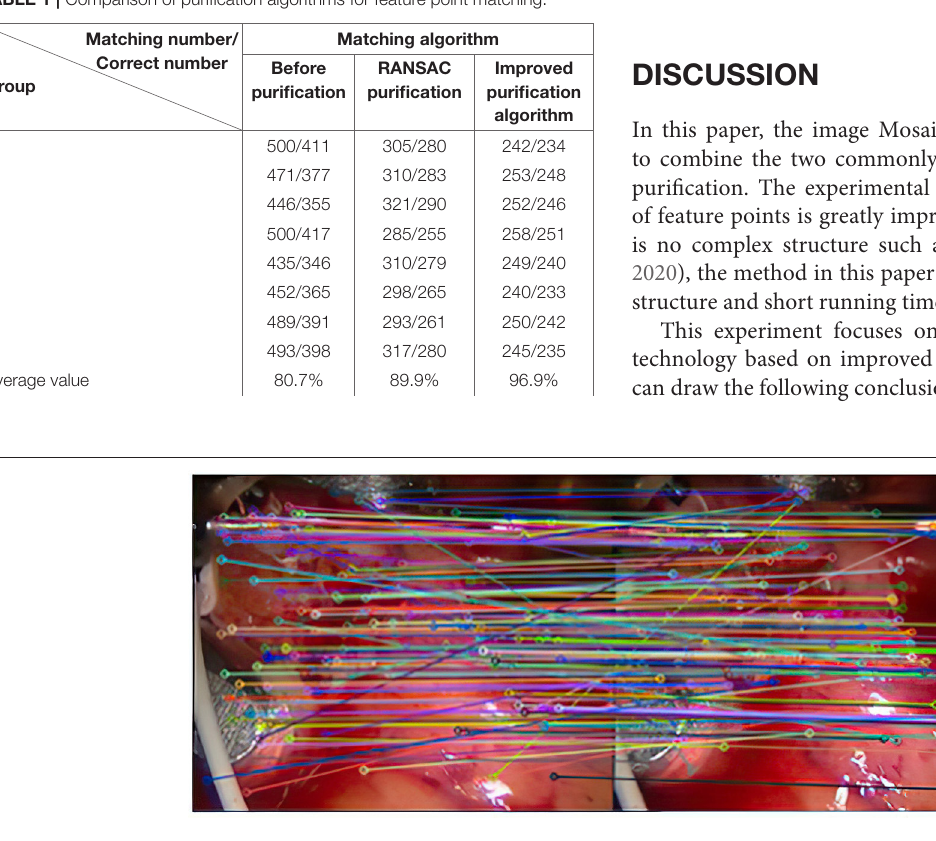
FIGURE 5 | Initial matching results of feature points.